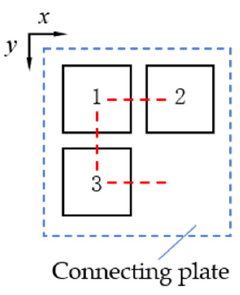
Figure 5. Three columns constrained by a connecting plate.